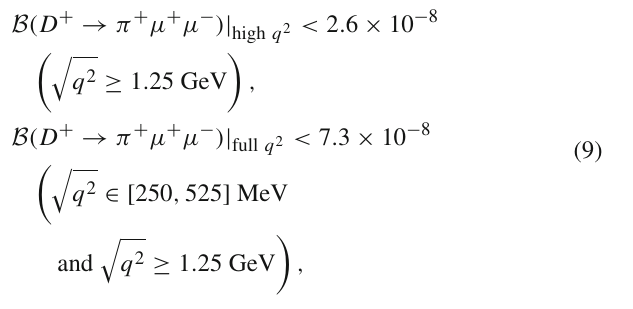
resonance parameters and μ c . Darker shaded thin curves represent all parameters set to their central values including δ ρ = 0 and δ φ = π (solid) and δ ρ = δ φ = 0 (dashed). For the experimental limit by LHCb [20] see Eq.